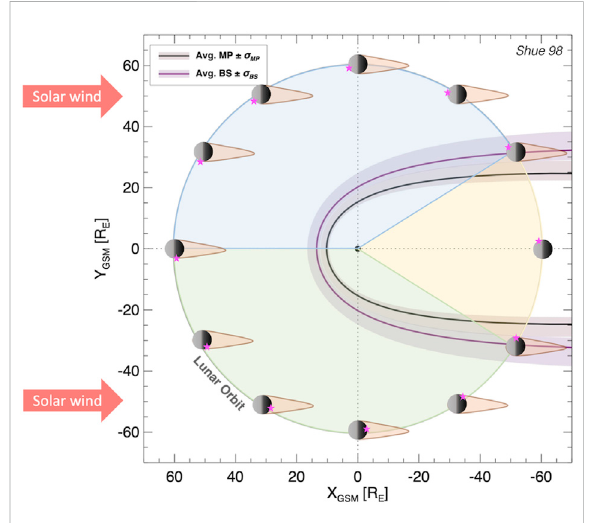
FIGURE 1 Depiction of the RG swirl (pink star) over one lunar orbit, rotating in and out of the lunar wake (orange tail) and Earth magnetopause (black line with salmon shaded variance) and bow shock(purplelinewithlilacshadedvariance)inanaberration- correctedframeofreference(Shueetal.1998;Jelineketal.,2012). The average magnetopause and bow shock location are based on 10 years(2010 – 2020)ofsolarwindand IMFobservationsfromthe OMNI dataset (Papitashvili and King 2020). Moon and wake scaled 200 × to visualize illumination at RG/LVx landing site. The blue slice of the orbit is when RG is outside of Earth ’ s magnetosphere (unabatedsolarwind),thegreensliceiswhenRGiswithinthelunar wake (attenuated solar wind), and the yellow slice is when RG is within Earth ’ s magnetosphere (no/minimal solar